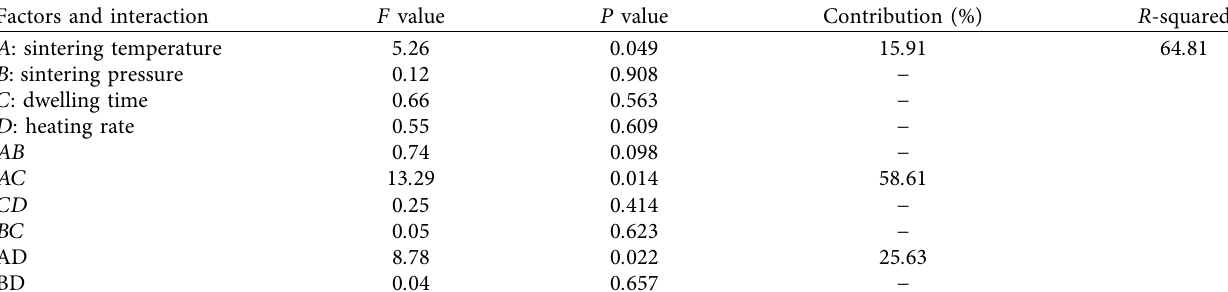
Figure 1: Relative density main effect plot of (a) means and (b) signal to noise Table 5: ANOVA results on microhardness.